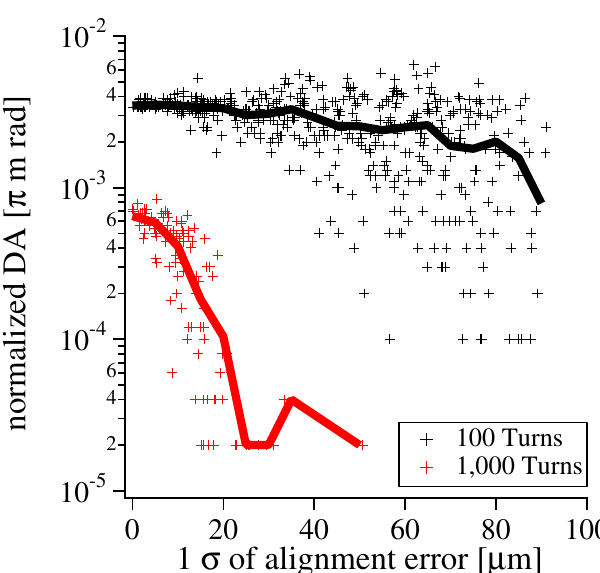
FIG. 5. (Color) Initial amplitude which was not accelerated to the final momentum. Black markers show 100 turns acceleration and red markers show 1000 turns acceleration. Solid curves show the average among the nearby